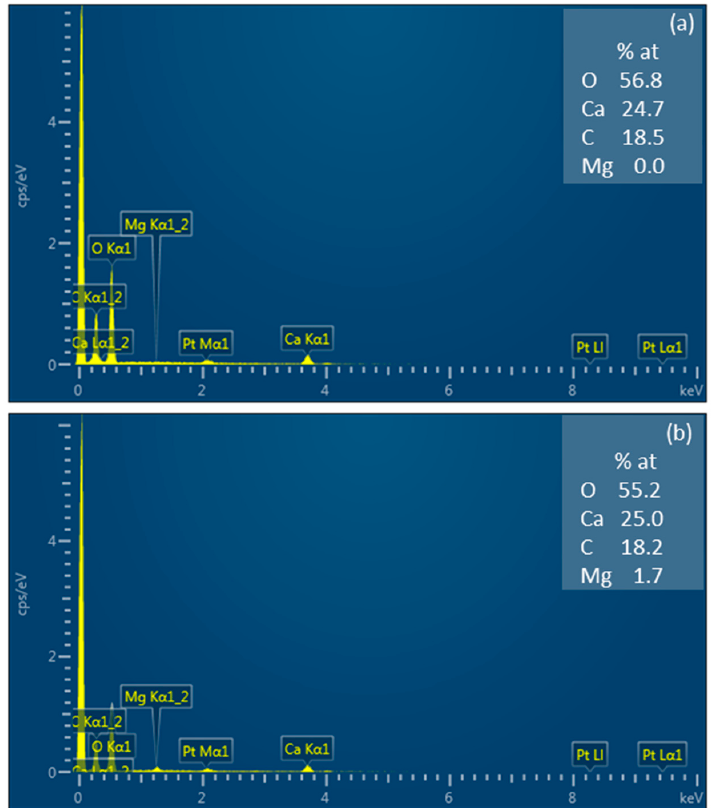
Figure 8. Energy dispersive X-ray spectroscopy of precipitate on the MK-40 membrane surface.